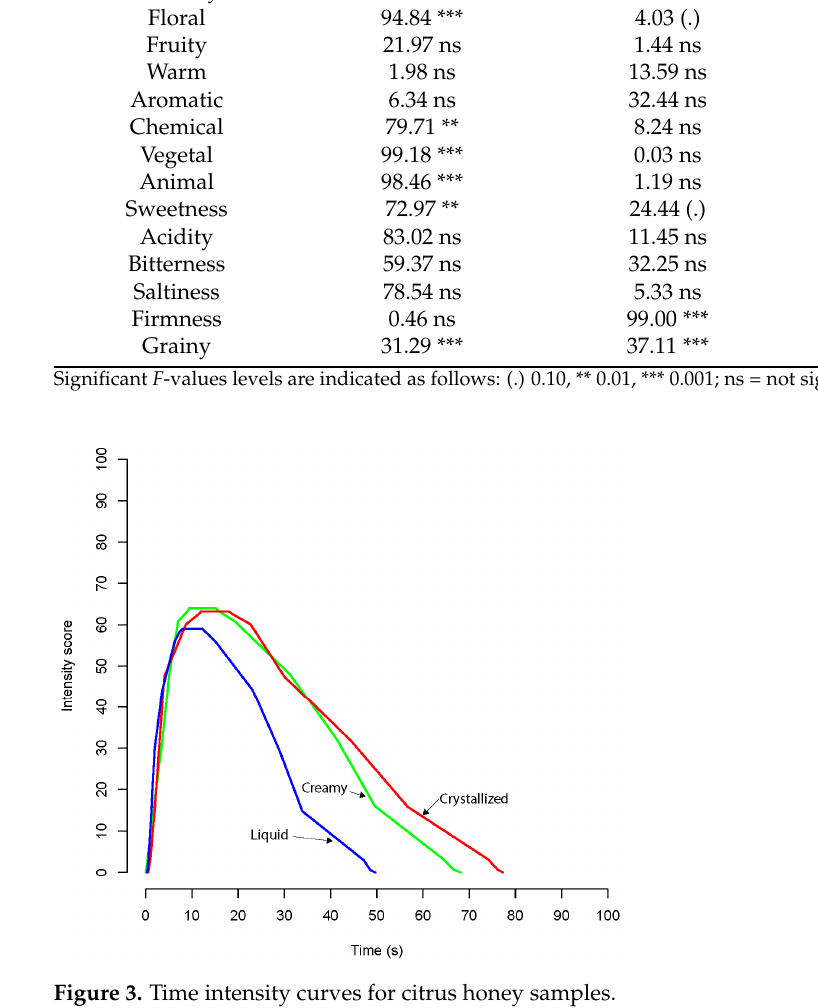
Figure 4. Time intensity curves for rape honey samples.